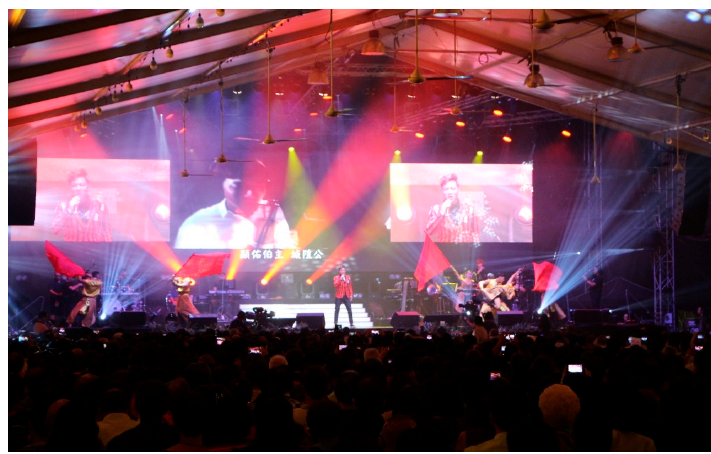
Figure 5. Popular Hokkien Music Singer, Weng You Li Sings the Sheng Hong Temple 100-year Anniversary theme Song (Image: Alvin Eng Hui Lim).